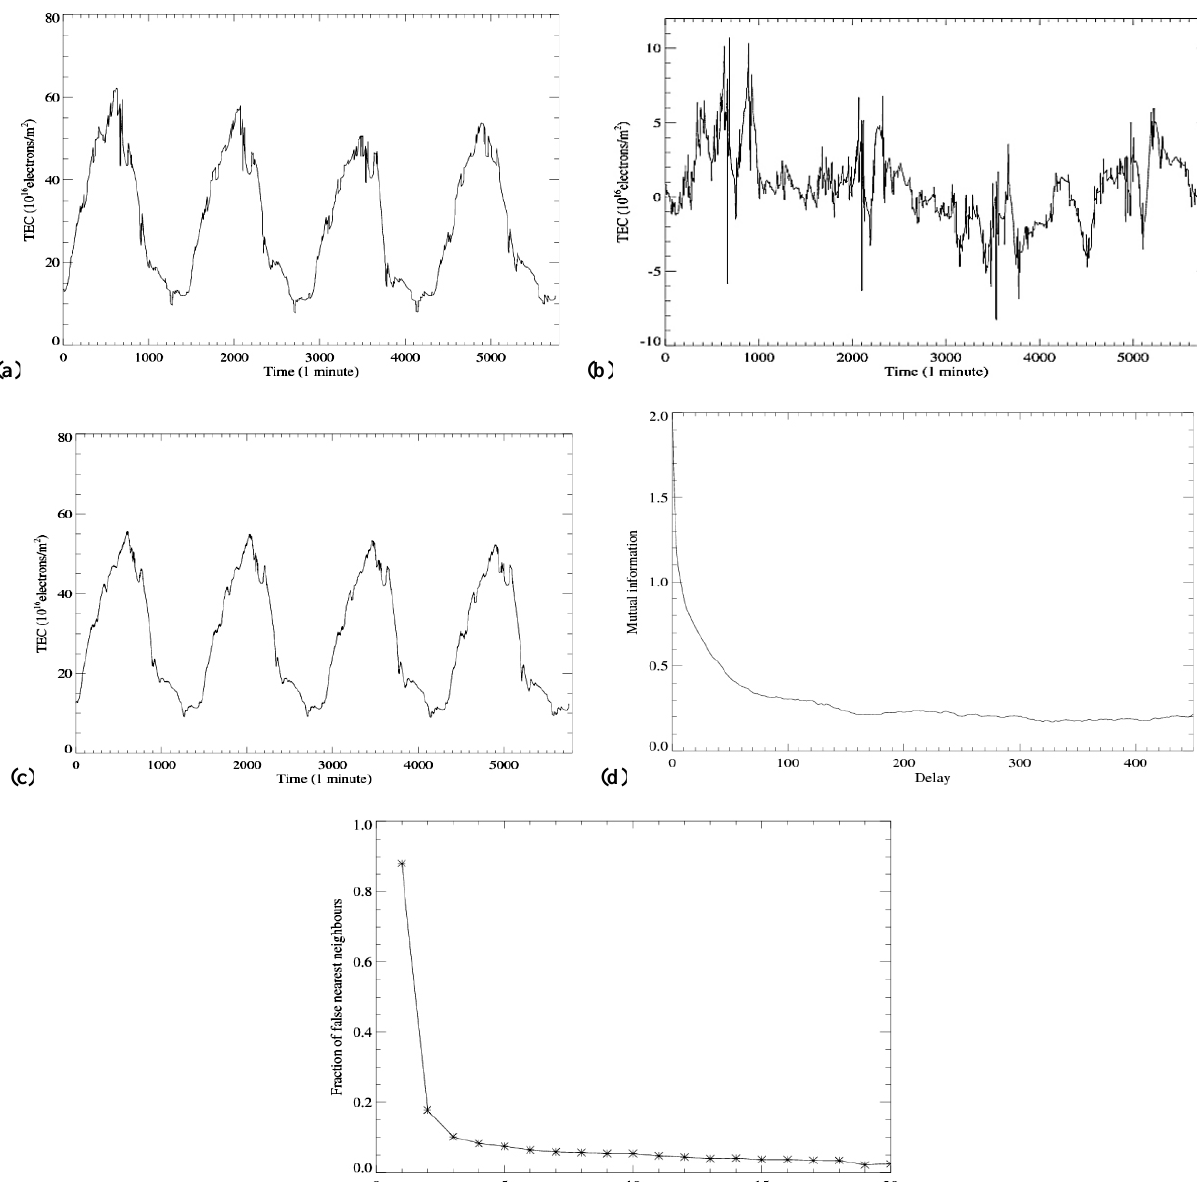
Fig. 1. (a) Time series of TEC, (b) detrended TEC, (c) variations of a i , (d) the mutual information of the detrended TEC as a function of delay, and (e) the fraction of false nearest neighbours as a function of the embedding dimension m with τ = 20, during the period 7–10 June 2005, measured at